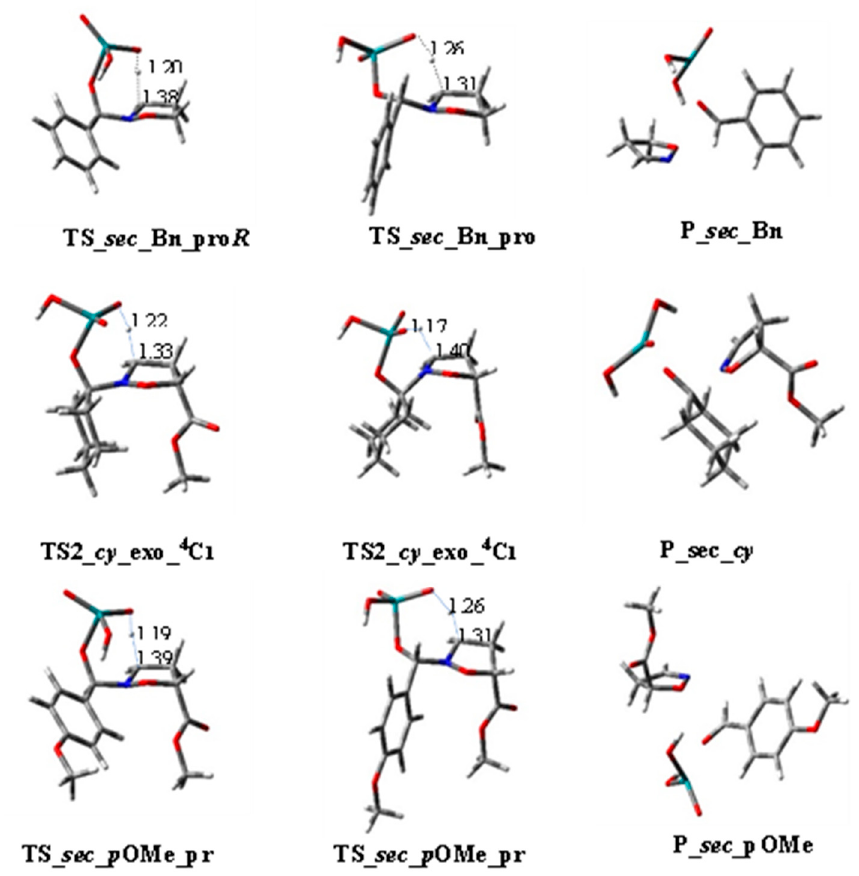
Figure 5. Three-dimensional plots of TSs_sec for compounds 1a and 1c , TSs2 for compound 1b, and the corresponding products P_sec . For TSs imaginary frequencies are shown as dotted lines and distances are reported in angstroms.